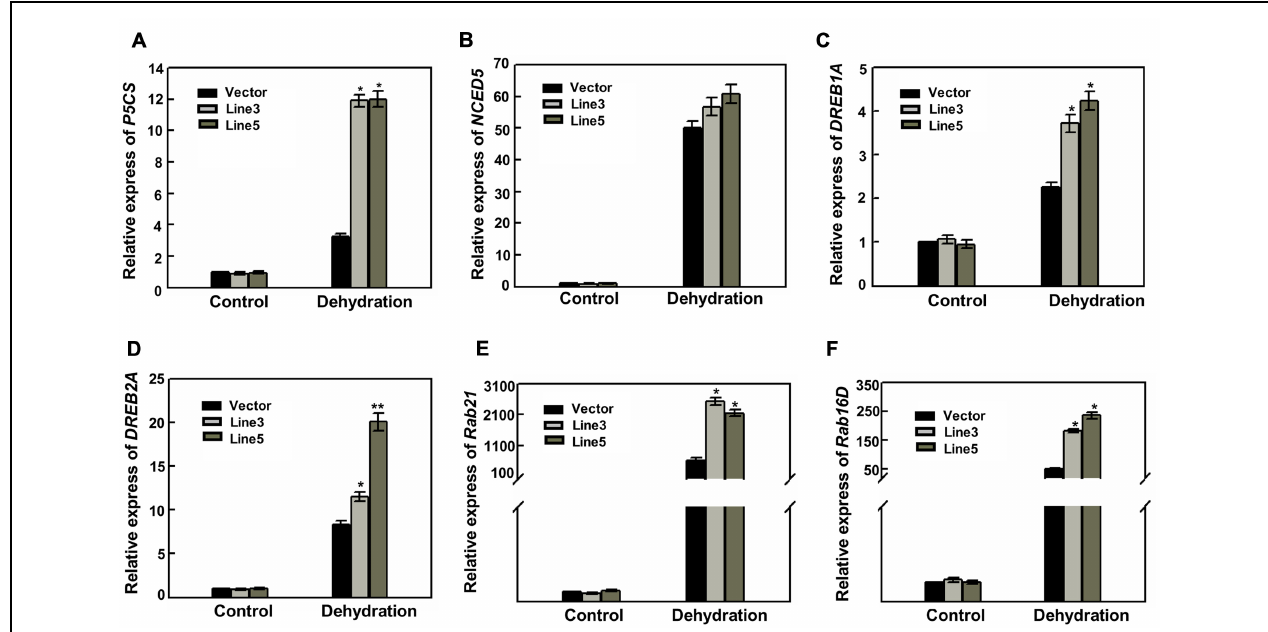
FIGURE 4 | High level expression of stress-responsive genes in transgenic rice. (A–F) Relative expression levels of P5CS , NCED5, DREB1A, DREB2A, Rab21 and Rab16D in the leaves of 4-week-old transgenic and control plants before and after drought stress. Values are the mean ± SE ( ∗ P < 0.05) of three independent